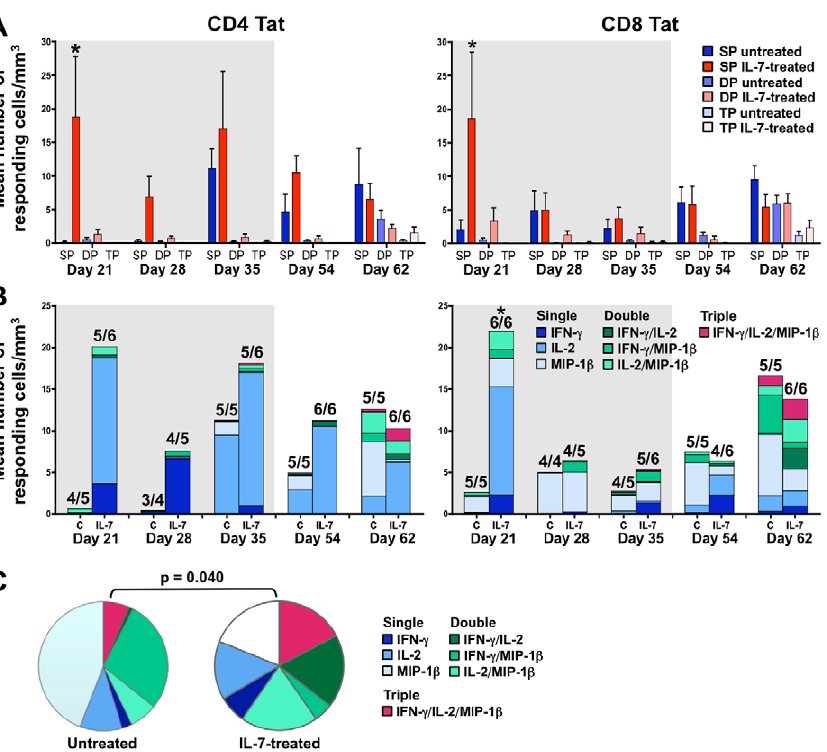
Figure 7. Qualitative analysis of SIV-specific T-cell responses in untreated and IL-7-treated macaques. (A) Mean absolute numbers ( 6 SEM) of CD4 + and CD8 + T cells producing one cytokine (single-producer, SP), two cytokines (double-producer, DP) or all three cytokines (triple- producer, TP) in response to SIV Tat peptide stimulation in untreated (shades of blue) and IL-7-treated (shades of red) animals. The asterisks indicate significant differences between SP T cells in untreated vs. IL-7-treated animals, as analyzed by Wilcoxon rank sum test. (B) Mean absolute numbers of SIV Tat-responding CD4 + and CD8 + T cells in untreated (U) and IL-7-treated (IL-7) animals. The bars indicate the mean numbers of total responding cells; the colors indicate the mean numbers of IFN- c , IL-2, or MIP-1 b SP cells (shades of blue), IFN- c /IL-2, IFN- c /MIP-1 b or IL-2/MIP-1 b DP cells (shades of green), and IFN- c /IL-2/MIP-1 b TP cells (purple). The numbers above each bar indicate the fraction of monkeys that gave a measurable response over background to SIV Tat peptides at the corresponding time point. The grey shaded areas indicate the IL-7-treatment period. The asterisk indicates a significant difference between total responses in IL-7-treated vs, untreated macaques. (C) Qualitative analysis of SIV Tat-specific CD8 + T-cell responses in IL-7-treated and untreated macaques on day 62 post-infection. The pie charts indicate the average contribution of the various functional subpopulations of Tat-responding CD8 + T cells (single-, double- and triple-producing, SP, DP, TP, respectively) to the total number of Tat-responding cells in untreated and IL-7-treated animals at day 62 post-infection. The p value was calculated by permutation analysis using the Spice